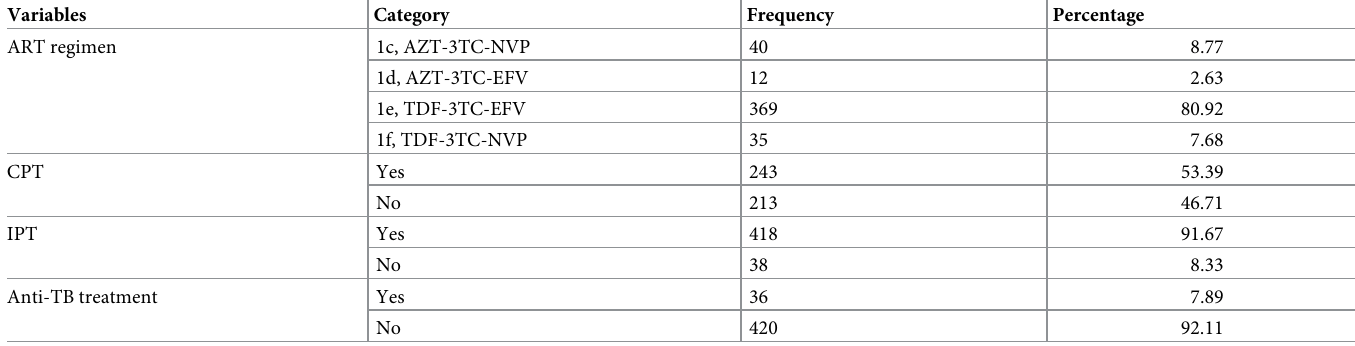
Table 4. ART and other medication related characteristics of HIV positive adults at initiation of HAART at Arba Minch town public health facilities, January 2013 to December 2018 (N = 456). Variables